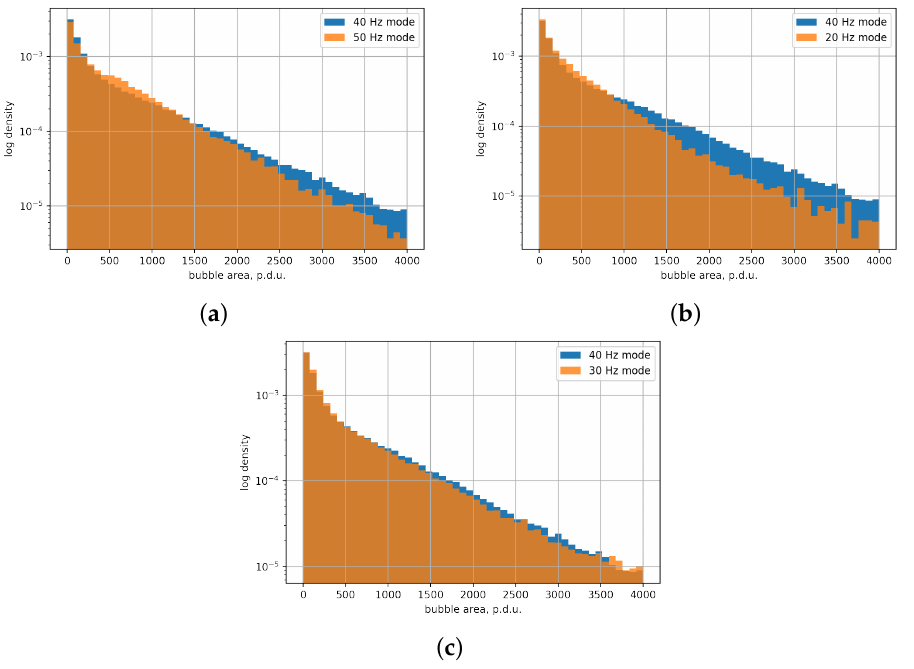
Figure 24. Comparison of logarithmic area distributions for ( a ) 40 Hz vs. 50 Hz, ( b ) 40 Hz vs. 20 Hz, ( c ) 40 Hz vs. 30 Hz bioreactor modes. One can see how the slope of the distribution changes for various bioreactor modes. The parameter of the exponential distribution might be used in order to parameterize bioreactor modes. However, it requires more datasets to measure and justify the